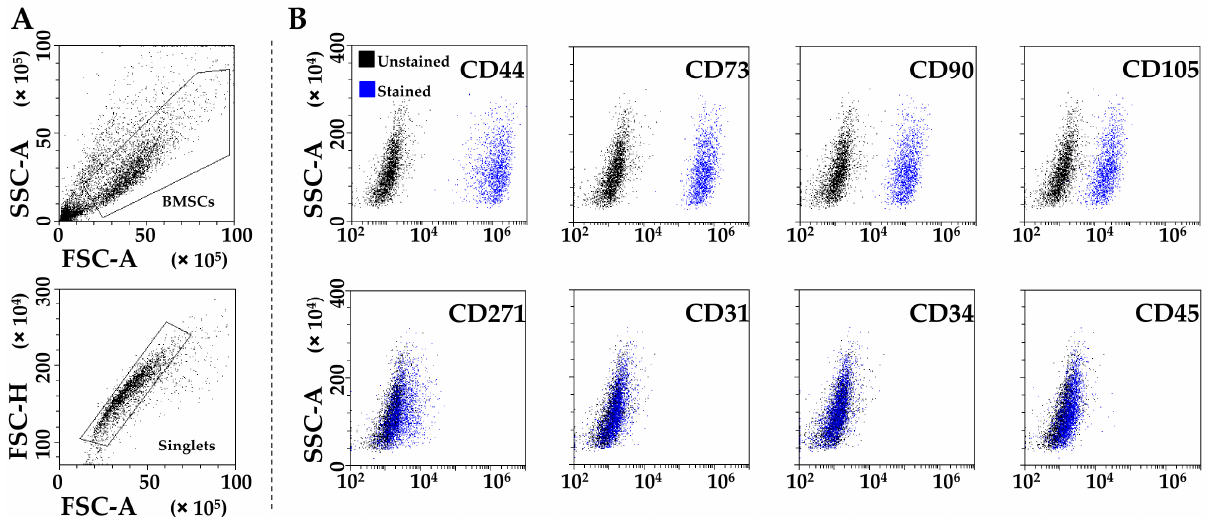
Figure 1. Flow cytometry analysis of PRP-treated BMSCs. ( A ) BMSCs’ identification after debris (upper panel) and aggregate (lower panel) exclusion. ( B ) BMSCs’ staining for general MSC (CD44, CD73, CD90, and CD105, highly positive), BMSC-specific (CD271, dim positivity), and hemato- endothelial (CD31, CD34, and CD45, negative) markers. Representative plots are shown.